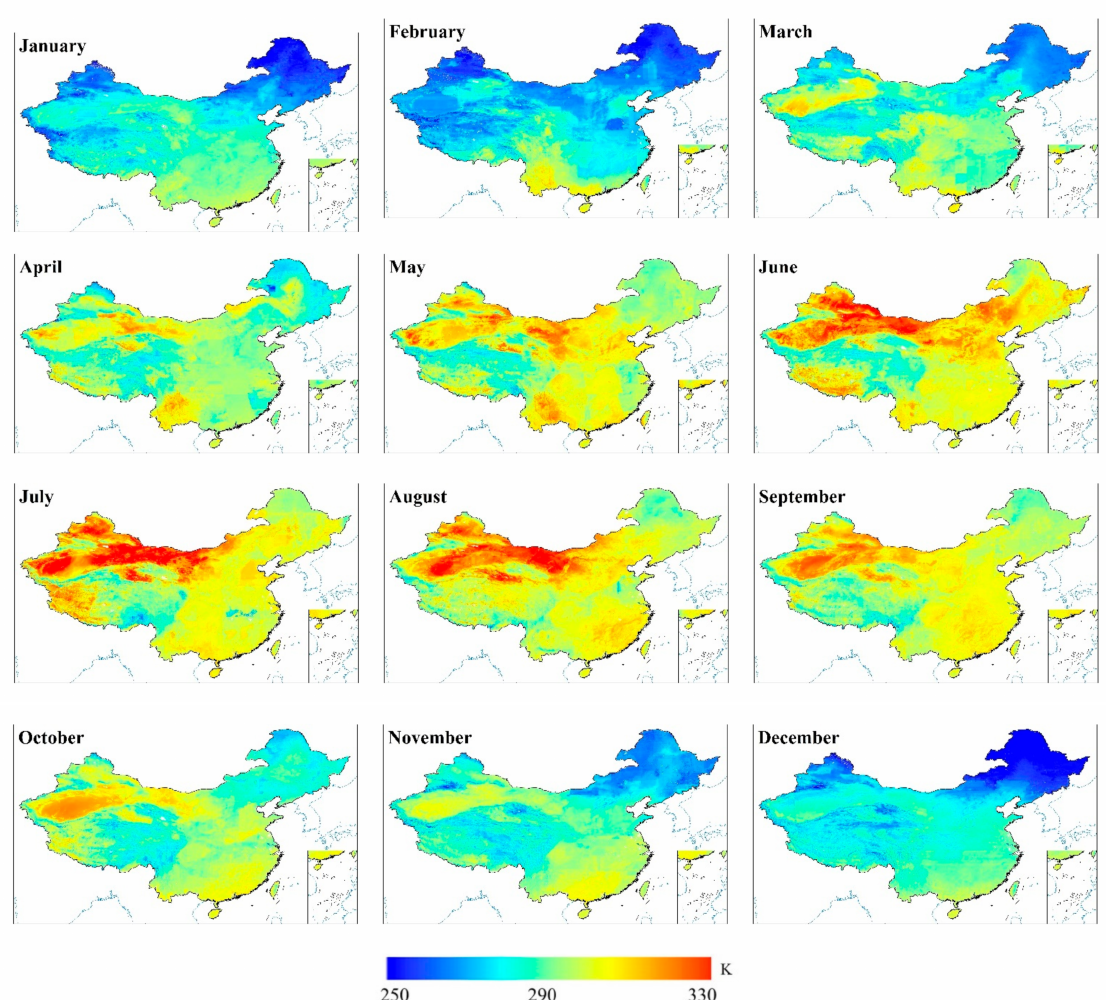
Figure 12. Spatial distributions of the complete all-weather LST during daytime of the 17th, 43rd, 75th, 107th, 139th, 163rd, 196th, 227th, 259th, 291st, 317th, and 345th days of the year 2010, representing different